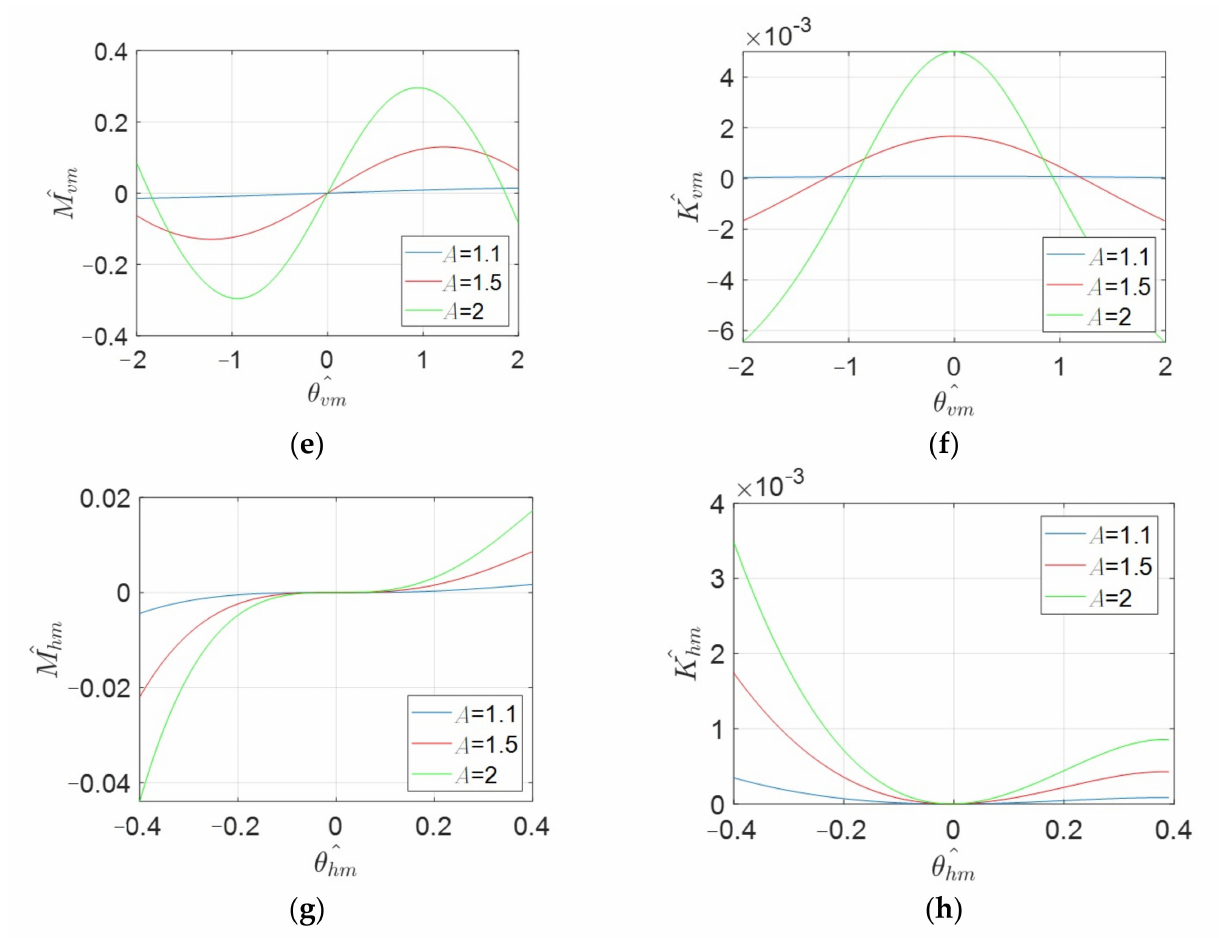
Figure 9. Variations of stiffness with displacement: ( a ) force in vertical displacement; ( b ) force in horizontal displacement; ( c ) force in vertical rotation; ( d ) force in horizontal rotation; ( e ) stiffness in vertical displacement; ( f ) stiffness in horizontal displacement; ( g ) stiffness in vertical rotation; ( h ) stiffness in horizontal